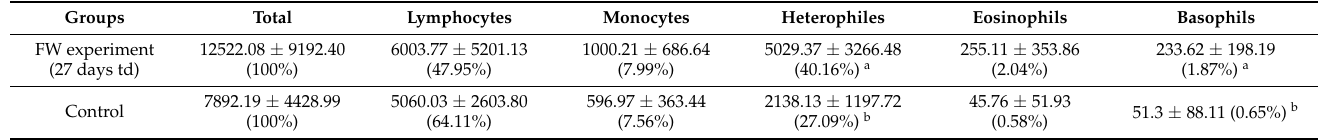
Table 2. Differential leukocyte count of SPF Leghorn birds at 27 days of treatment (td) with 3.3% NaCl in feed and 7 days with 1% NaCl in drinking water (FW experiment).